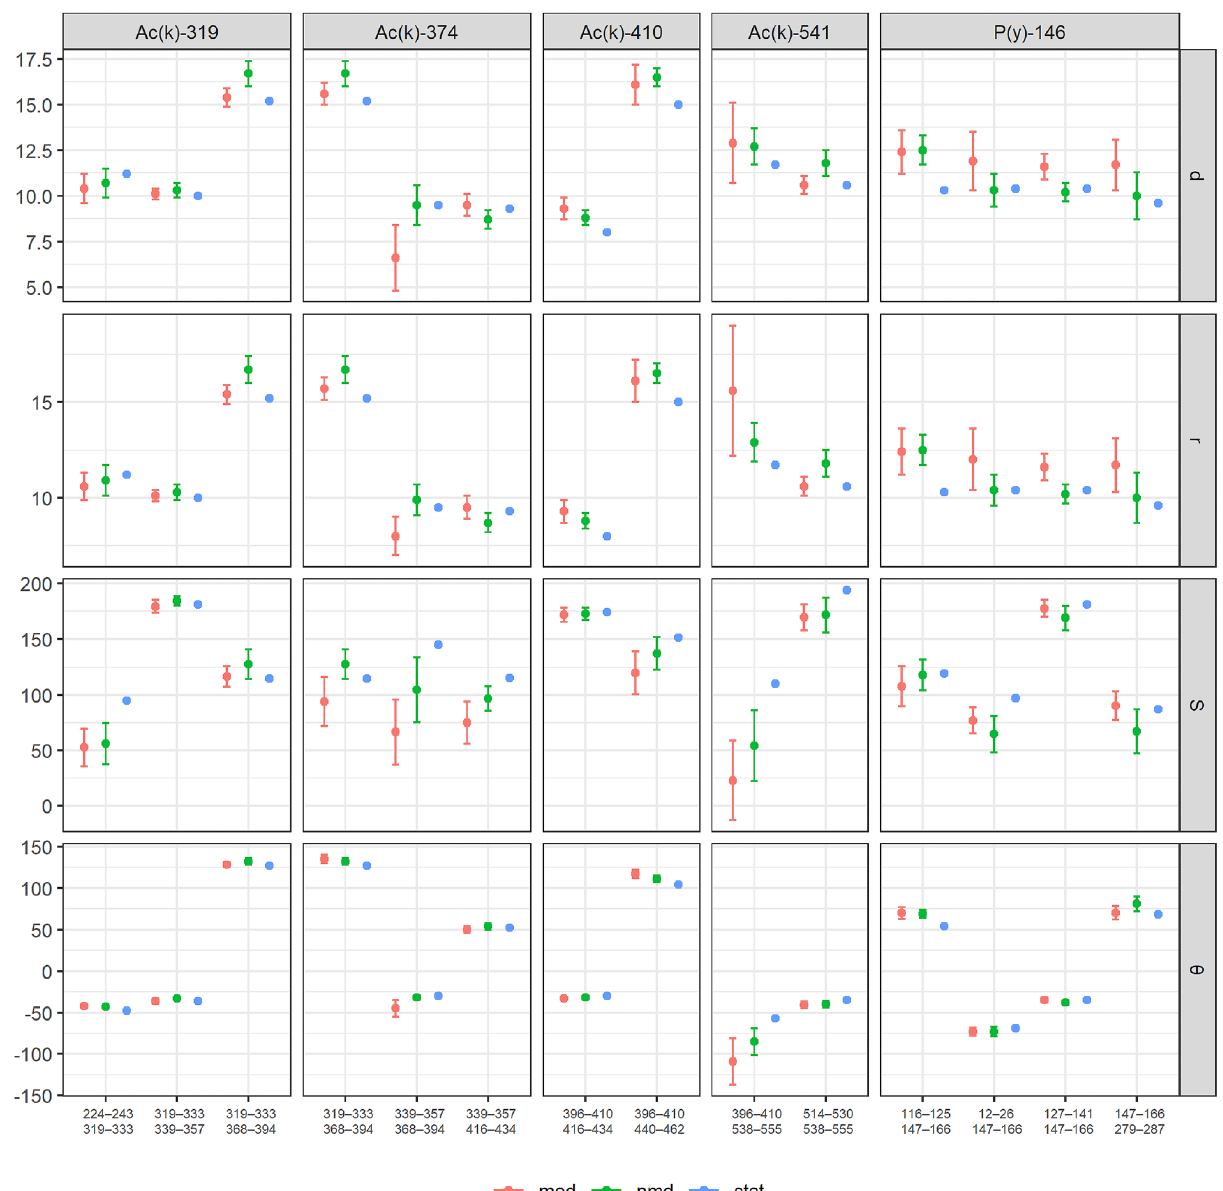
Figure 5. Calculated geometrical features of albumin (ALBU) motives with PTM moiety. Each motif is characterized by the estimated geometrical features for intact molecule ( stat ; blue color), calculated results of molecular dynamics for the unmodified molecule ( nmd ; green color), and calculated features for the modified molecule ( mod ; red color). The right axis indicates (d) distances between helices, (r) inter-planar distance between helices, S—area of the spatial projection, and θ—torsion